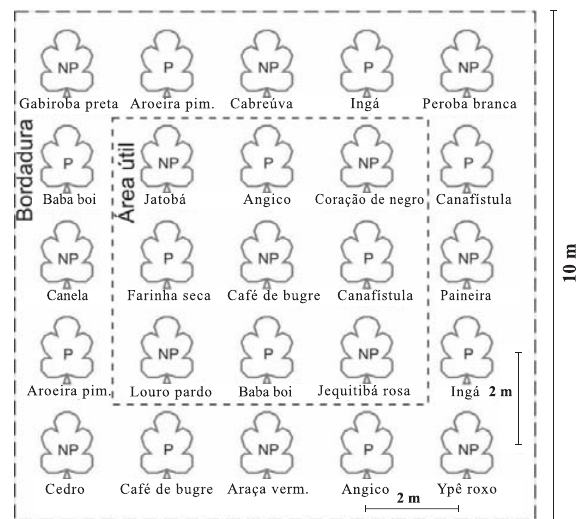
Figura 1. Esquema de uma parcela, delimitando o espaçamento de plantio, as bordaduras e as espécies utilizadas (NP: não pioneira, P: